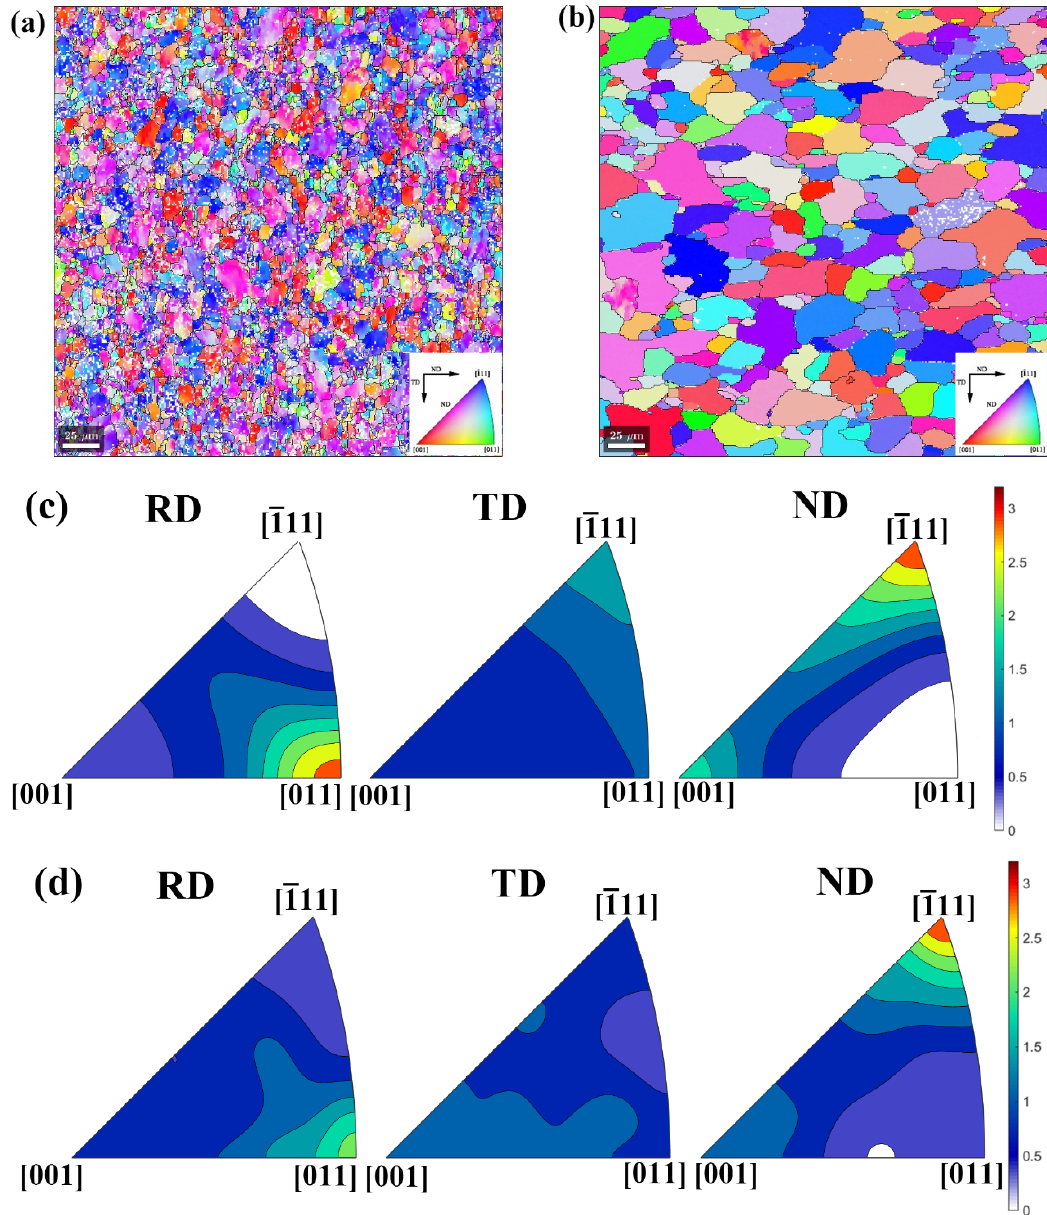
Figure 3. Orientation maps (top) and IPFs (bottom) of the TD–ND surface of the rolled sample ( a , c ) and fully recrystallized sample ( b , d ).